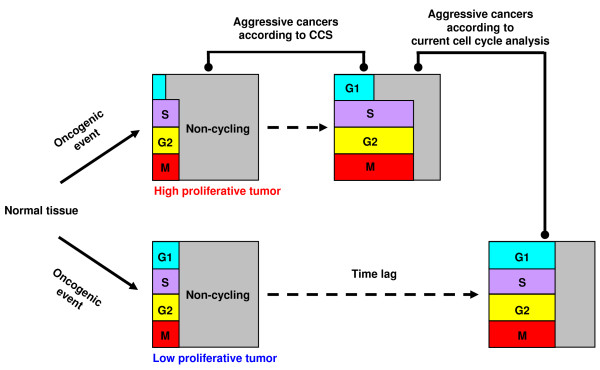
A model of tumors with different cell cycle phase distributions. Oncogenic events perturb the cell cycle each in their unique way, which alters cell cycle phase distribution as well as proliferation rate. High proliferative tumors grow rapidly and produce large number of cycling cells, but exceptions exist at a low probability. CCS can characterize them under consideration of cycling and non-cycling cells.